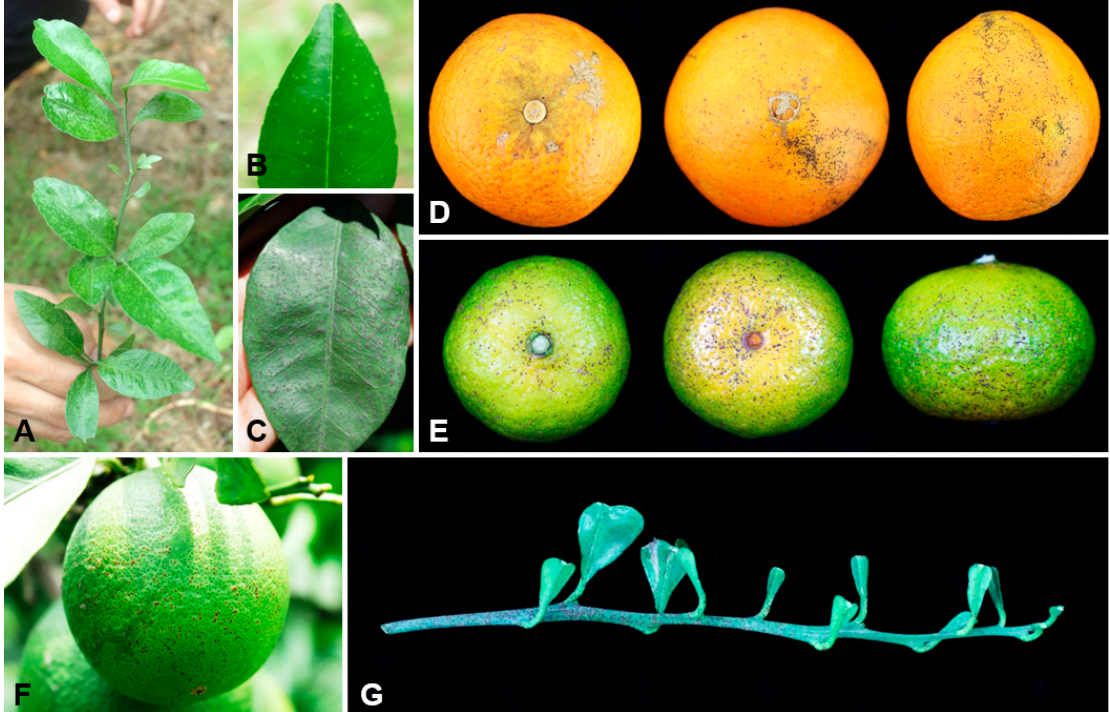
Figure 1. Symptoms of citrus melanose caused by Diaporthe species. ( A , B ) Typical symptoms on young leaf of Citrus reticulata cv. Nanfengmiju . ( C ) Typical symptoms on old leaf of C. sinensis . ( D , E ) Typical symptoms on mature fruits of C. sinensis and C. reticulata cv. Nanfengmiju , respectively. ( F ) Typical symptoms on young fruit of C. sinensis . ( G ) Twig typical symptoms of C. sinensis .